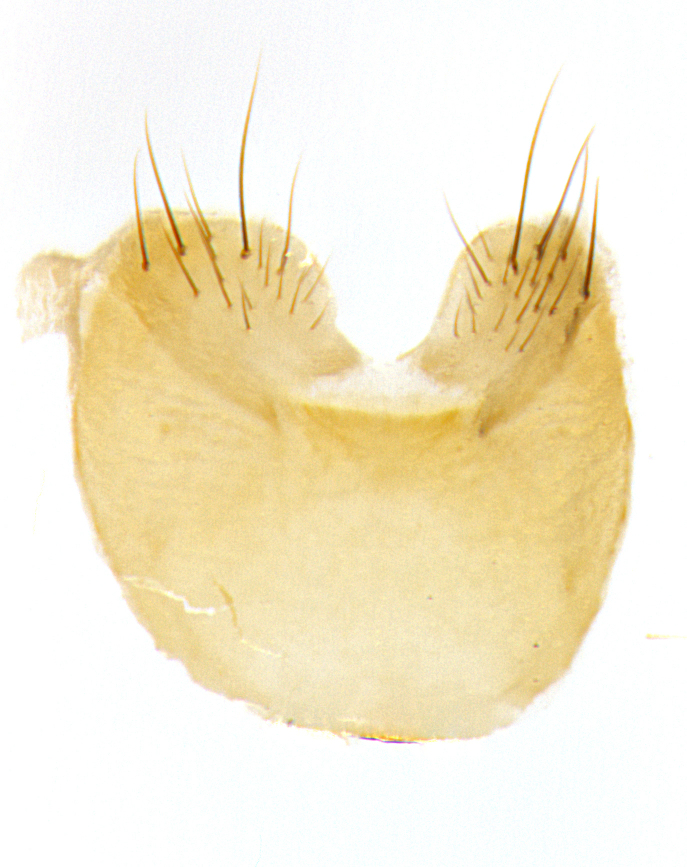
sternite 5, ventral view.